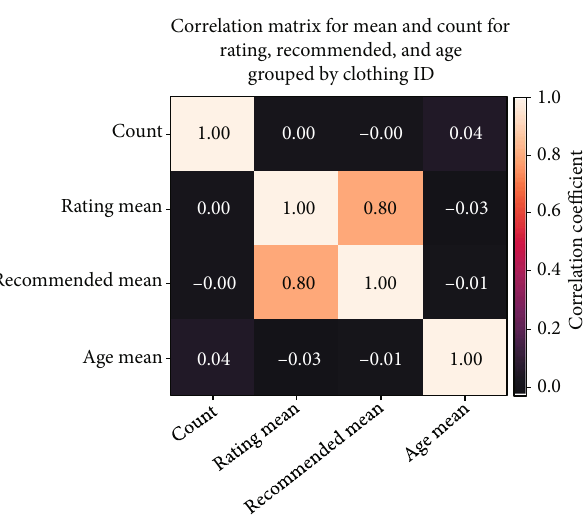
Figure 19: The heat map showing the correlation between recommended IND by clothing ID and